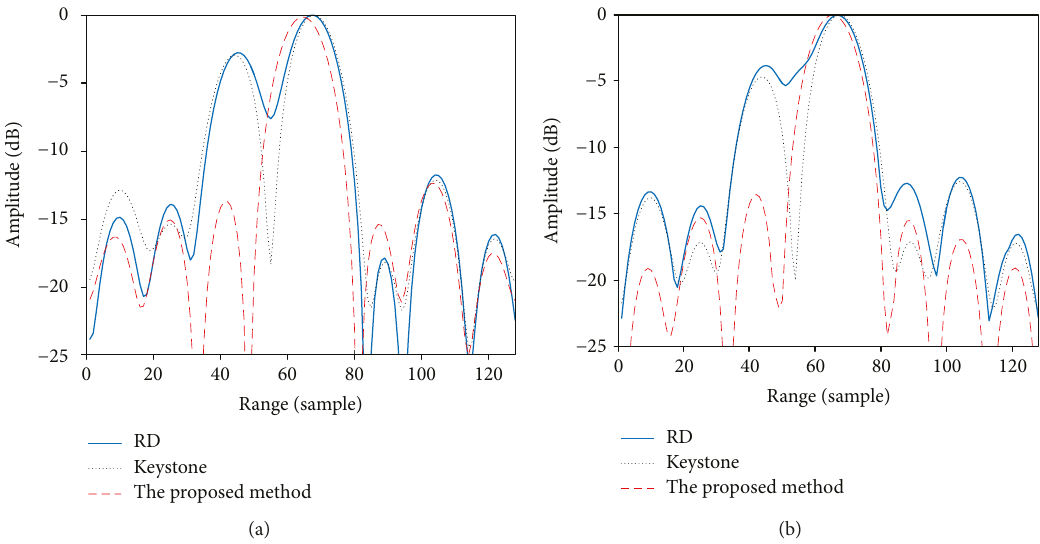
Figure 8: Pro fi le comparison of the scattering point marked by the red circle in Figure 4. (a) Comparison in range. (b) Comparison in